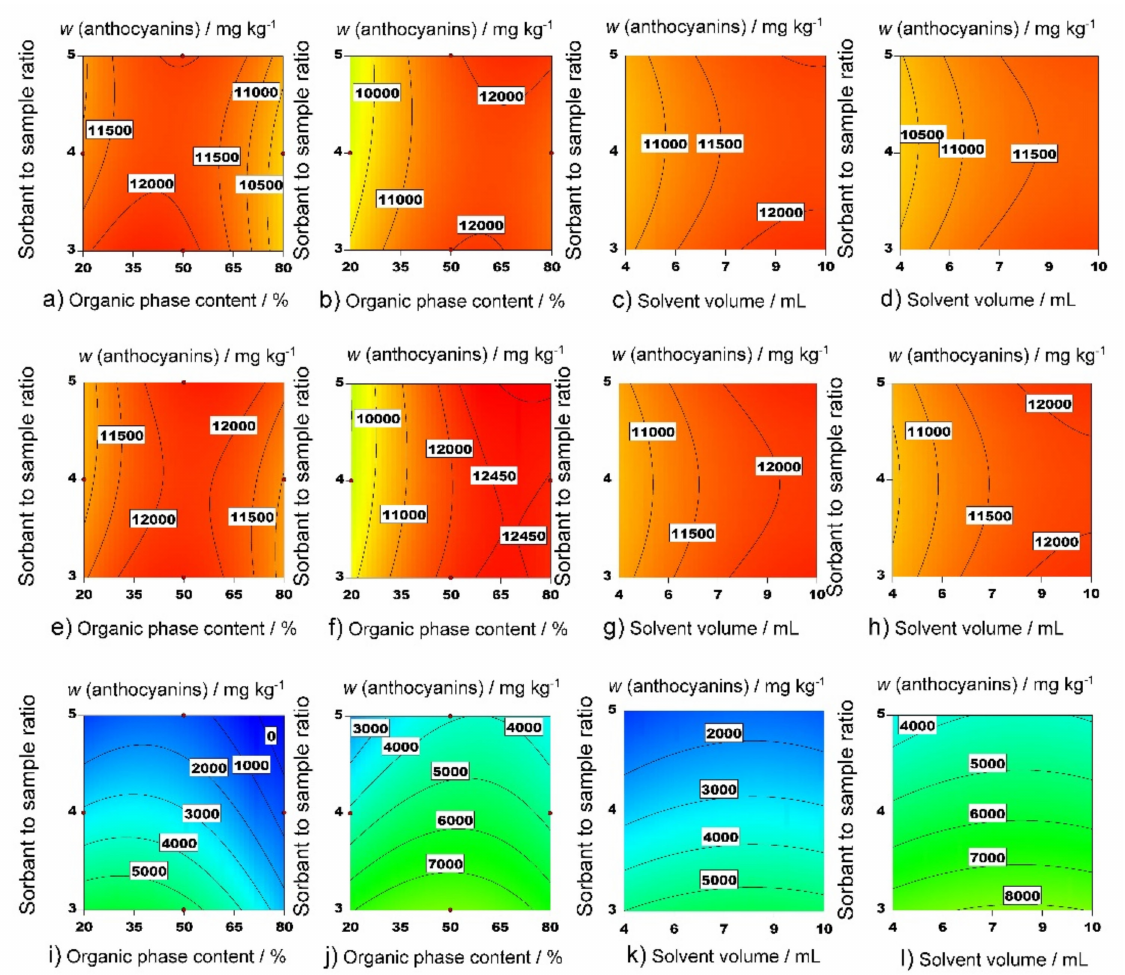
Figure 5. Contour plots of the most significant interaction effects between individual extraction factors on the content of anthocyanins when using ( a ) sea sand and acetonitrile and ( b ) sea sand and ethanol with an elution solvent volume of 10 mL, ( c ) sea sand and acetonitrile and ( d ) sea sand and ethanol with a volume content of the organic phase in the elution solvent of 50%, ( e ) phenyl silica and acetonitrile and ( f ) phenyl silica and ethanol with an elution solvent volume of 10 mL, ( g ) phenyl silica and acetonitrile and ( h ) phenyl silica and ethanol with a volume content of the organic phase in the elution solvent of 50%, ( i ) XAD-2 and acetonitrile and ( j ) XAD-2 and ethanol with an elution solvent volume of 10 mL, and ( k ) XAD-2 and acetonitrile and ( l ) XAD-2 and ethanol with a volume content of the organic phase in the elution solvent of